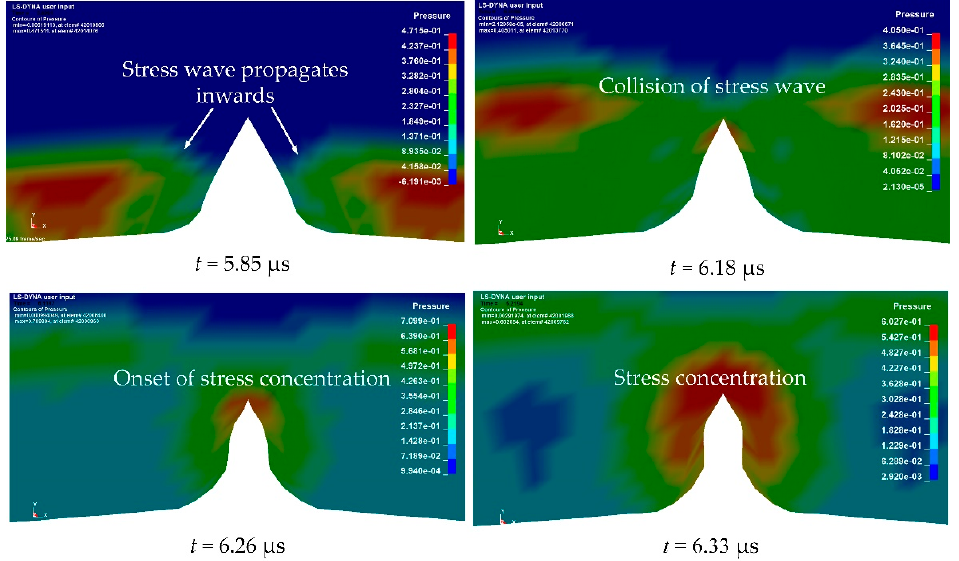
Figure 6. Numerical observations of the stress wave propagation and onset of stress concentration inside the grooved shell with R 0 = 50 mm, h = 6 mm, t = 2.4 mm, and θ = 60 degrees at 5.85, 6.18, 6.26, and 6.33 μ s after detonation.